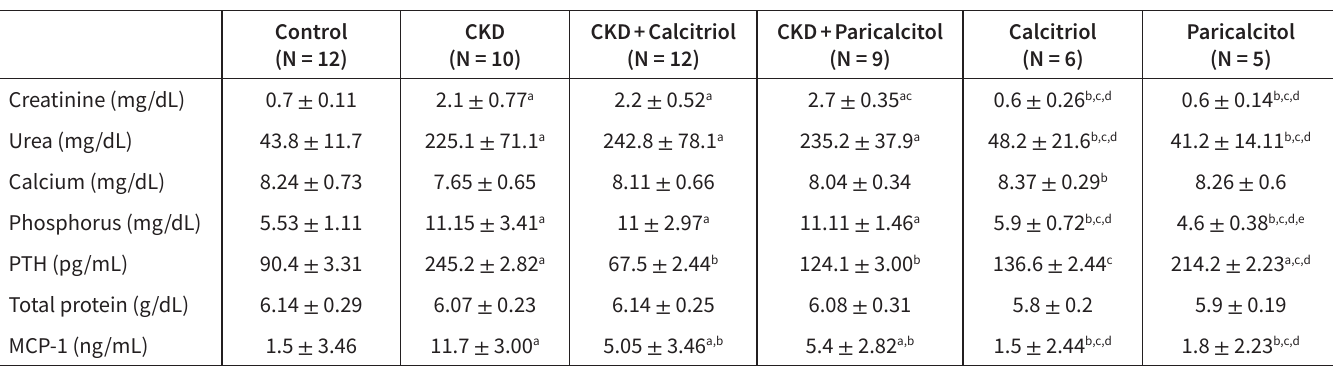
Table 2. Serum Chemistries in Normal and Uremic